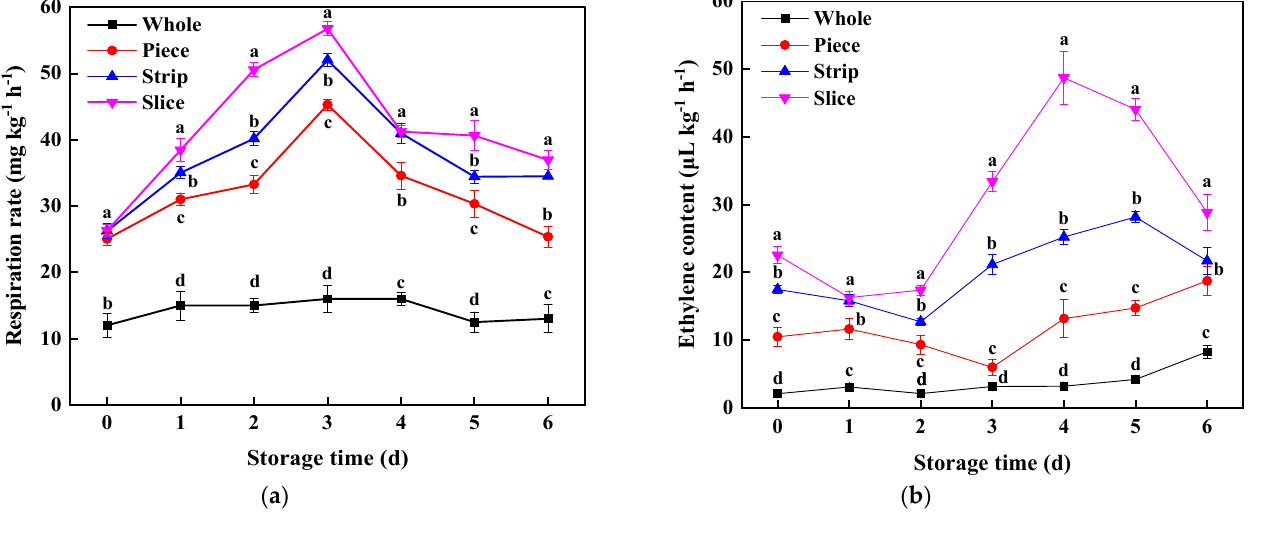
Figure 3. Effect of wounding intensities on respiration rate ( a ) and ethylene content ( b ) of fresh-cut pumpkin during storage at 4 ◦ C for 6 days. Vertical bars represent the standard deviation of the mean (n = 3). Different letters indicate significant differences between the groups ( p <